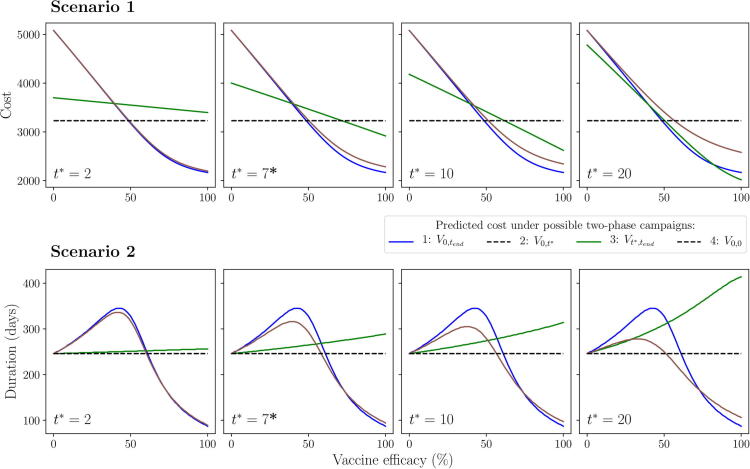
Effect of the value oft∗on campaign performance – Scenarios 1 and 2. All other parameters are fixed to the values given in Table A.2. Asterisks identify the default value for t∗ used in each scenario.